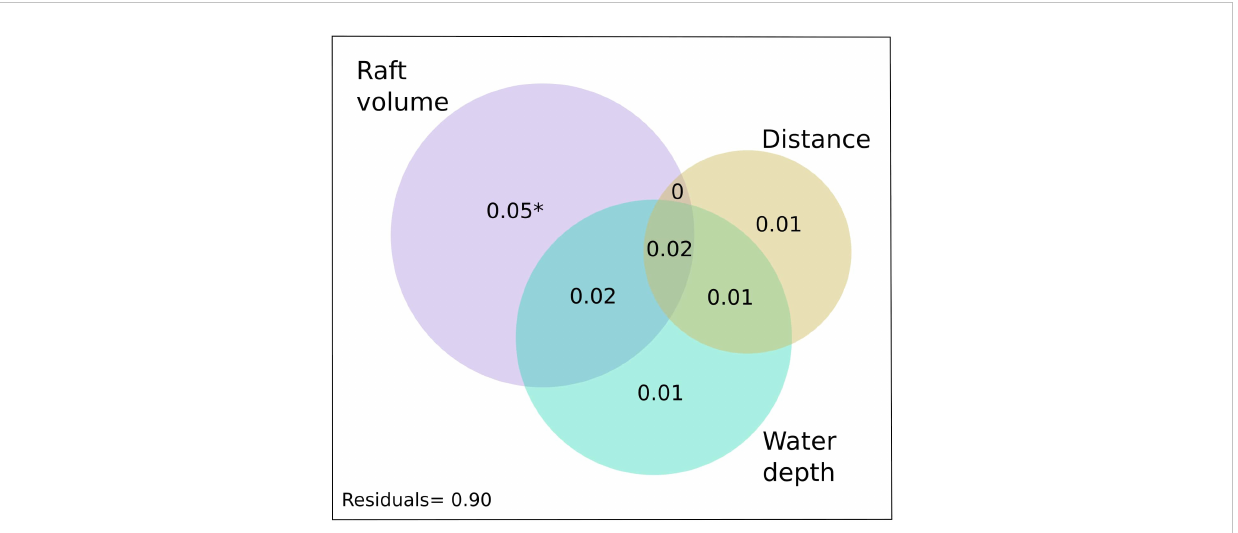
FIGURE 5 Venn diagram representing the shared and independent effects of each environmental variable on the assemblage of free-swimming fauna associated with pelagic sargassum. The variance jointly explained by distance, water depth and raft volume is represented in the region where all three circles overlap. Note that the sizes of the various shared and non-shared effects are only approximations.